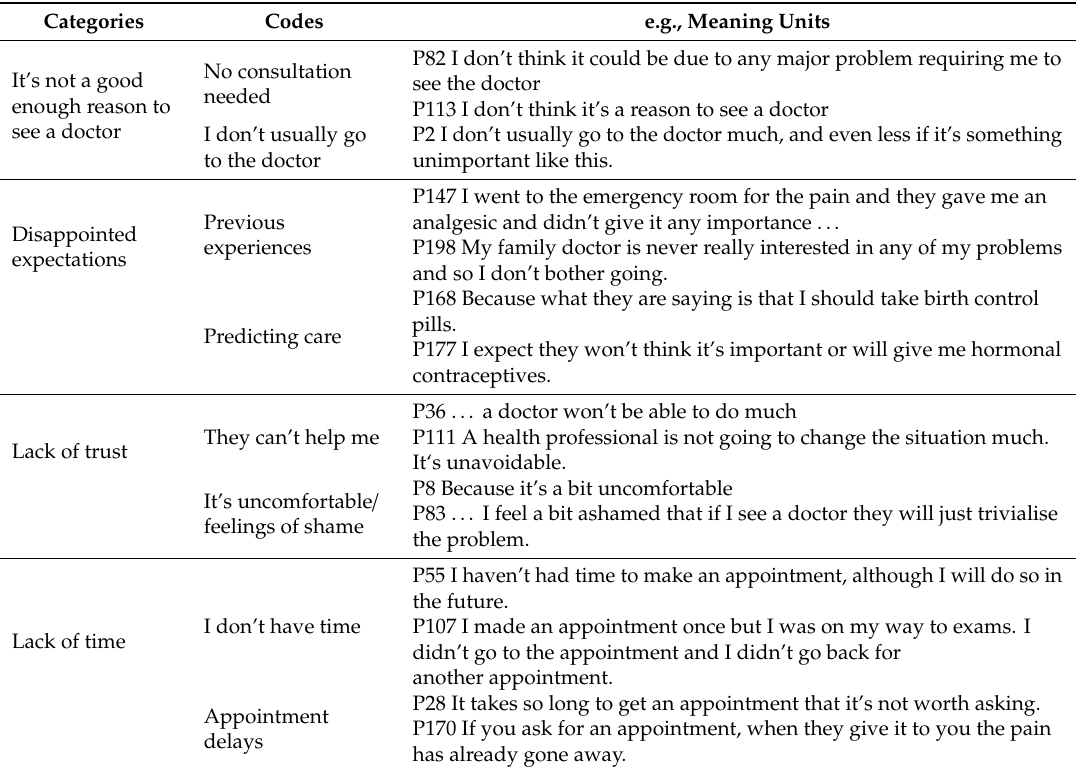
Table 4. Categories, codes and examples of the theme “Low expectations regarding health care”. Categories Codes e.g., Meaning